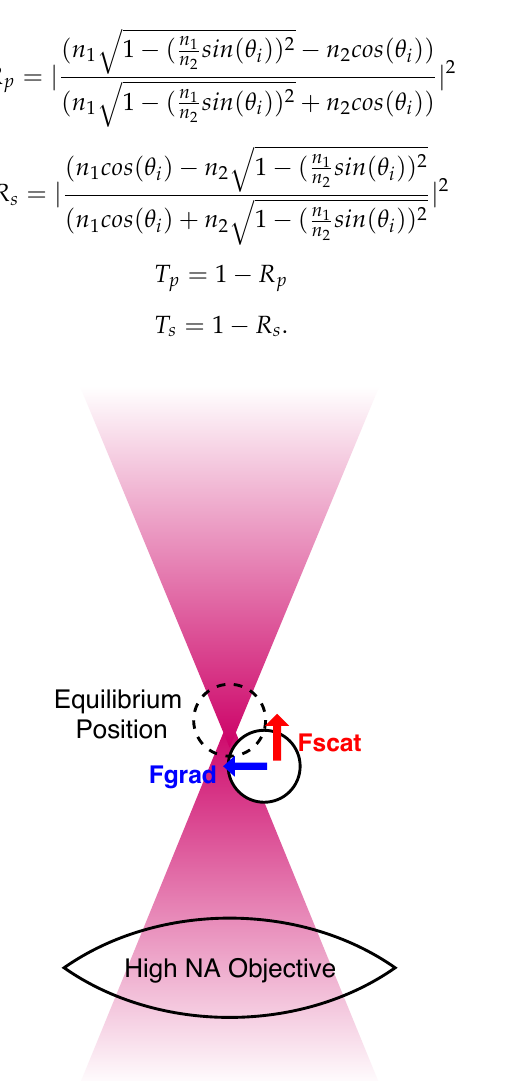
Figure 1. Optical tweezer theory treats the force associated with the focussed laser beam as two components, which can be visualised as resulting from the intense focussing of the